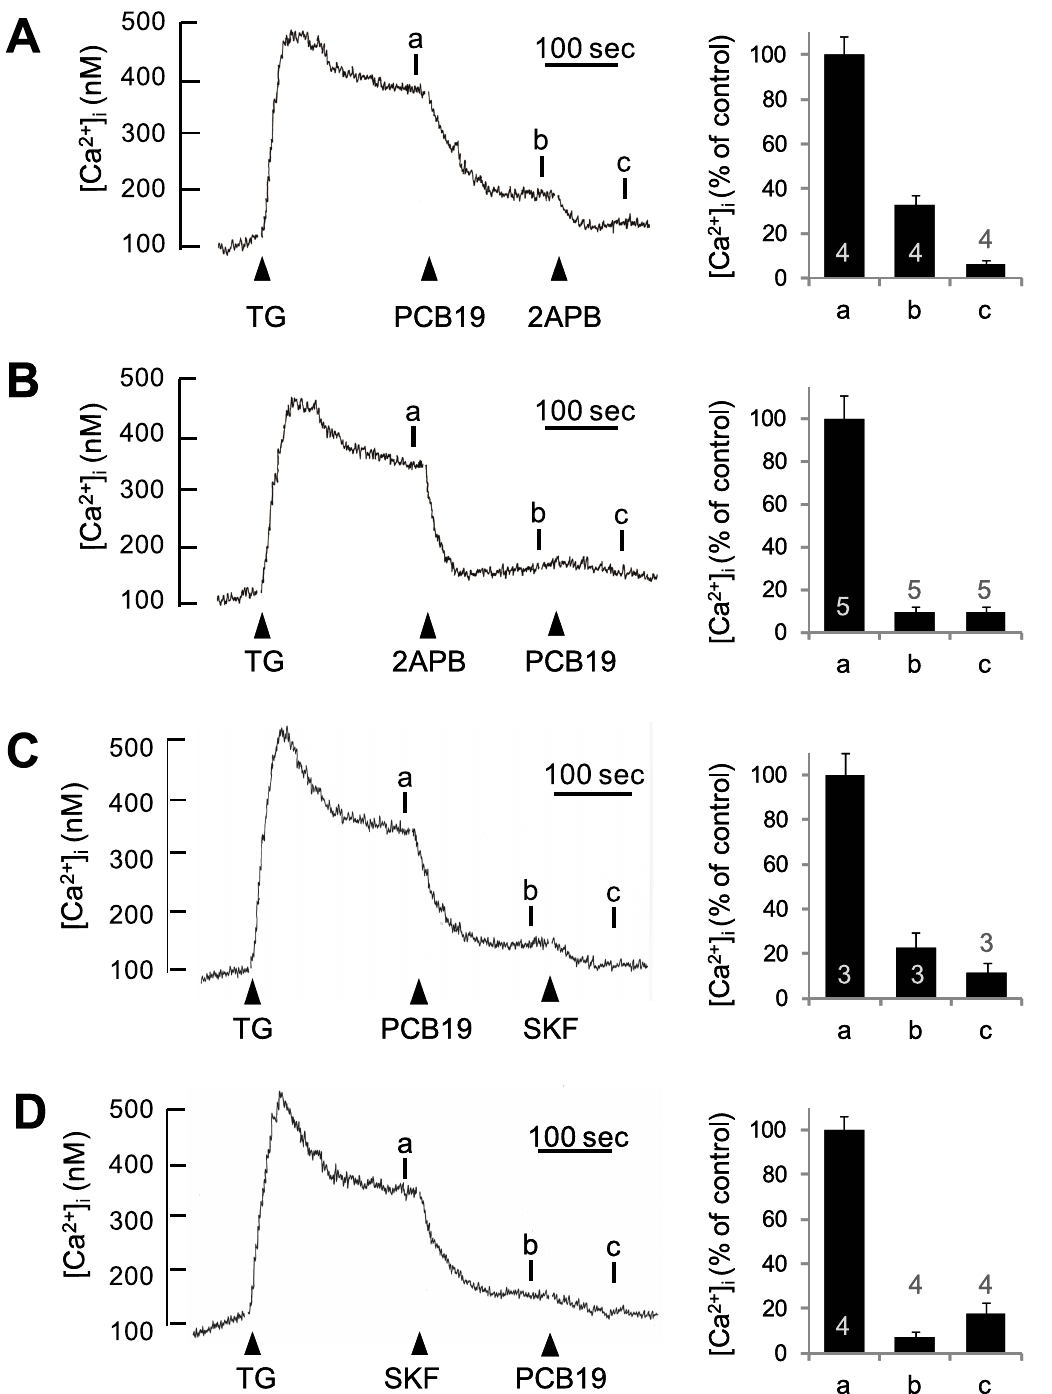
Fig 8. PCB19 inhibits thapsigargin-induced SOCE in a manner similar to other SOCE antagonists. A, Fura-2-loaded PC12 cells were treated with 1 μ M thapsigargin (TG), then sequentially challenged with 100 μ M PCB19 and 30 μ M 2-aminoethylphenyl borate (2APB). B, Cells were treated with 1 μ M thapsigargin, challenged with 20 μ M 2APB, and then treated with 50 μ M PCB19. C, Cells were treated with 1 μ M thapsigargin, then challenged sequentially with 100 μ M PCB19 and 20 μ M SK&F96365 (SKF). D, Cells were treated with 1 μ M thapsigargin, challenged with 20 μ M SK&F96365, and then treated with 50 μ M PCB19. The [Ca 2+ ]i level at point a , b , and c were quantitatively analyzed using calcium traces. Number of experiments are depicted in bar graph and each point represents mean ± SEM.